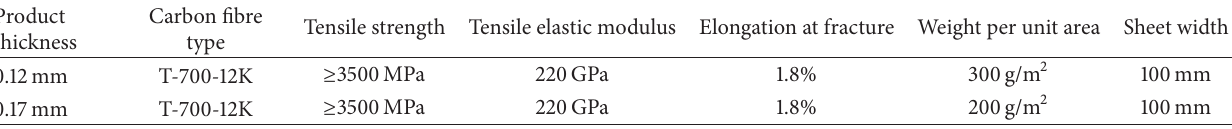
Table 1: Specifications and parameters of the CFRP sheets used in the experiments.